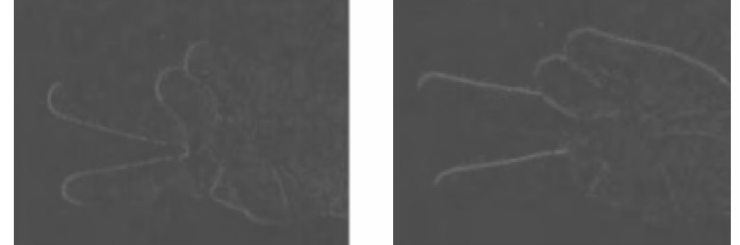
Figure 4. Extracted image features of convolution kernel